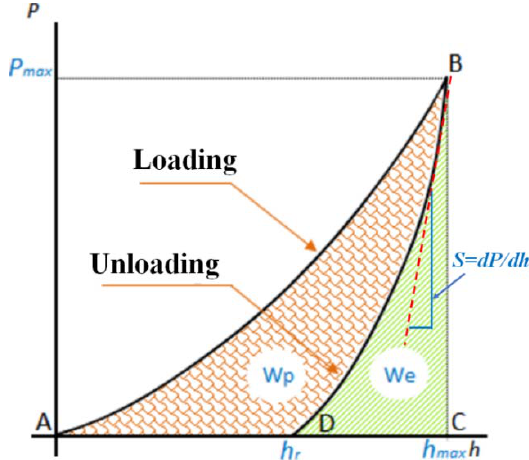
Figure 7. Typical Load vs. Penetration depth curve.